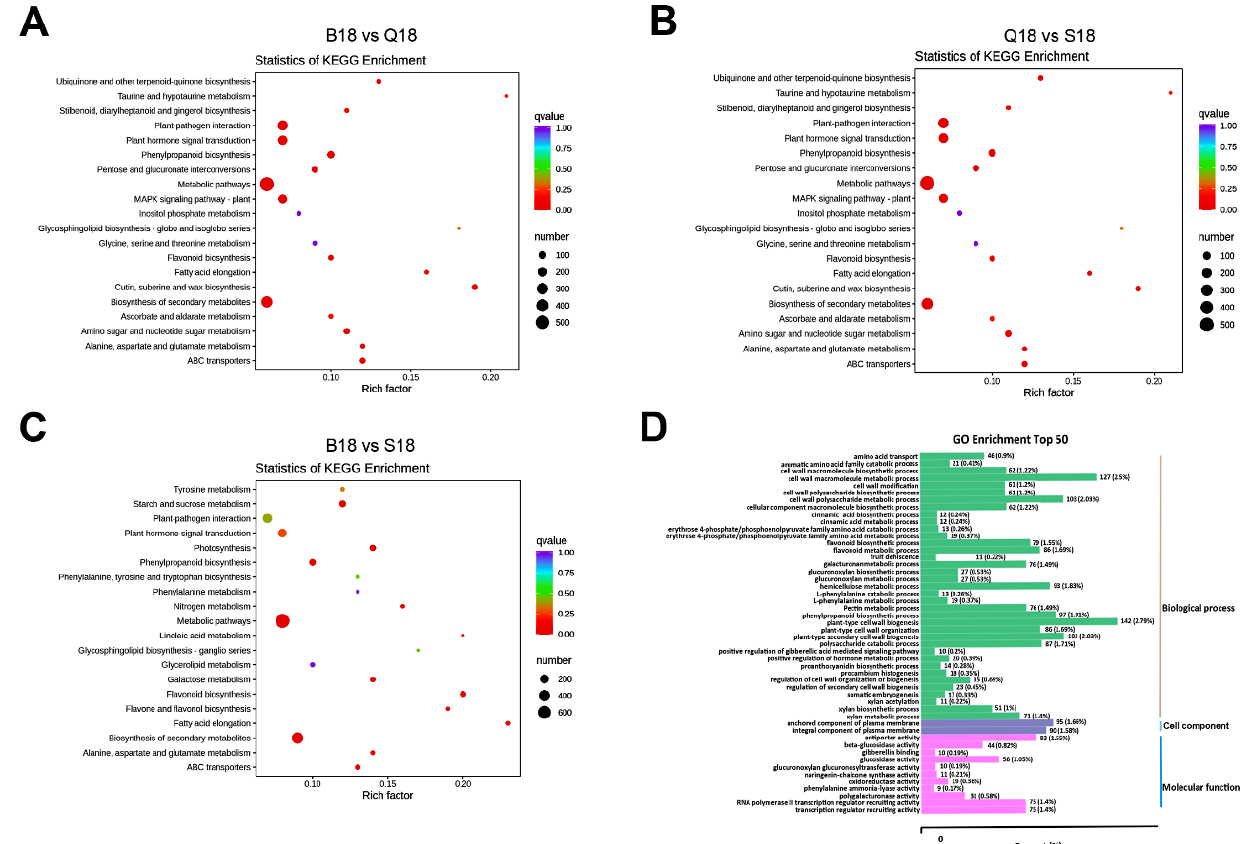
Figure 5. Results of top 20 KEGG and 50 GO enriched pathways analysis at 18 DPA. ( A ) KEGG enriched pathways between DCF and LCF. ( B ) KEGG enriched pathways between LCF and WCF. ( C ) KEGG enriched pathways between DCF and WCF. Q-value is a p -value that has been adjusted for the false discovery rate (FDR). The lower q-value indicates that a lower percentage of significant results will be false positives. Rich factor represents the degree of enrichment of genes under the designated pathway term. The greater the rich factor value, the greater the degree of pathway enrichment. ( D ) Fifty GO enriched pathways analysis. Green represents enrichment in biological process, purple represents enrichment in cell components, and pink represents enrichment in molecular function.